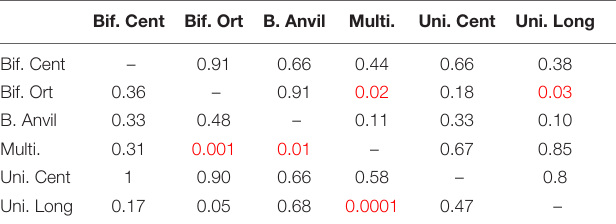
TABLE 2 | Upper triangle: Mann–Whitney pairwise tests ( p ) comparing the Estimated Original Mass (EOM) between knapping strategy; Lower triangle: Mann–Whitney pairwise tests ( p ) comparing the Estimated Percentage of Extracted Mass (EPEM) between knapping strategy. Bif. Cent Bif. Ort B. Anvil Multi. Uni. Cent Uni.